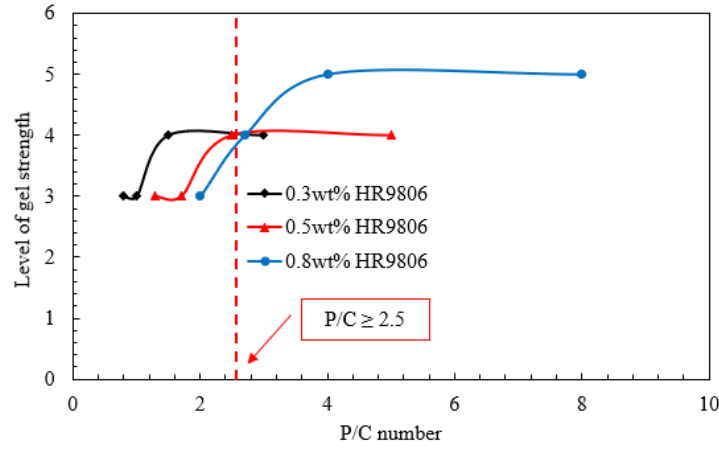
Figure 6. Gel strength of emulsion polymer solution at different P/C.